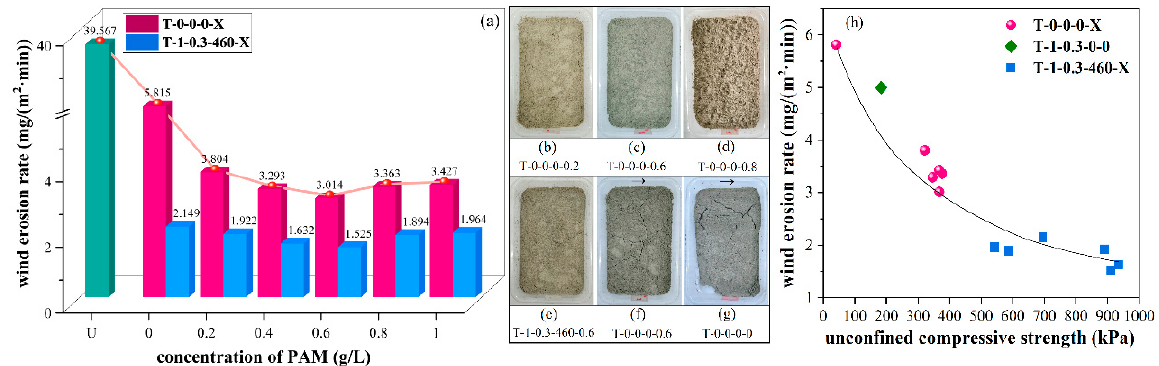
Figure 4. Wind erosion of samples treated with different solutions (the direction of the arrow in the physical photo represented the wind direction). ( a ) the WER of samples changed with the increase in PAM concentration; ( b – d ) the surface “crust” of the samples changed from smooth to rough after being cured with different concentrations of PAM; ( e ) the surface “crust” of the sample treated by PAM-EICP solution is denser; ( f ) FA particles could escape from cracks on the surface of the samples treated by PAM after wet-dry and freeze-thaw cycles; ( g ) the frost-resistance of the samples treated by deionized water was weak; ( h ) the correlation between the WER and the